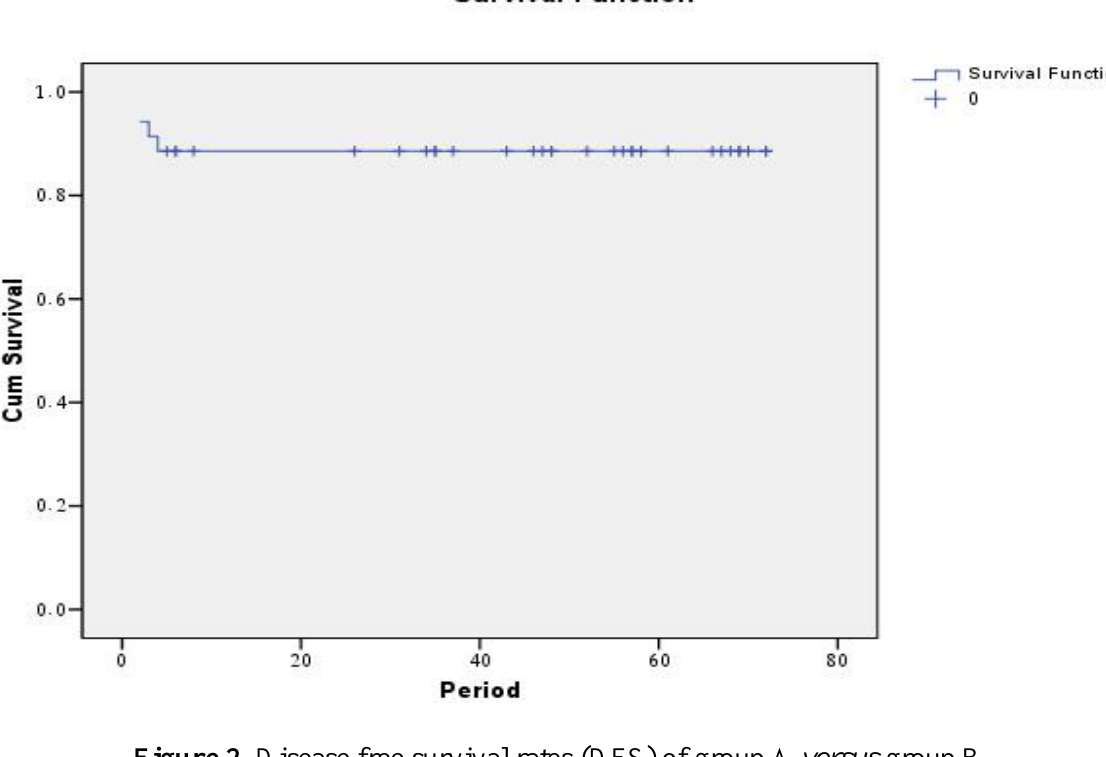
Figure 2. Disease free survival rates (DFS) of group A versus group